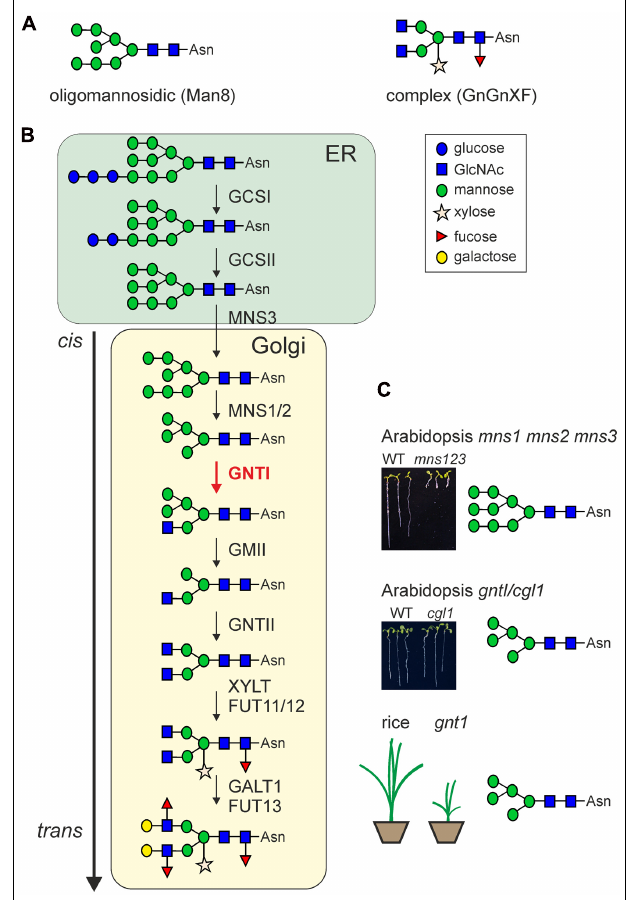
FIGURE 1 | (A) Examples for two characteristic types of N -glycans linked to the Asn–X–Ser/Thr sequence of proteins: oligomannosidic (e.g., Man8) and complex-type (e.g., GnGnXF) N -glycans. (B) Possible route in the formation of complex N -glycans in plants. Upon transfer of the preassembled oligosaccharide, the first N -glycan trimming reactions are catalyzed by α -glucosidases I (GCSI)/ II (GCSII) and α -mannosidase 3 (MNS3). Complex N -glycan formation is initiated in the Golgi apparatus by β 1,2- N -acetylglucosaminyltransferase I (GNTI, highlighted in red). MNS1/2, Golgi α -mannosidase I (two forms with largely redundant function are present in A. thaliana ); GMII, Golgi α -mannosidase II; GNTII, β 1,2- N -acetylglucosaminyltransferase II; XYLT, β 1,2-xylosyltransferase; FUT11/12, core α 1,3-fucosyltransferases (two forms with largely redundant function are present in A. thaliana ); GALT1, Lewis-type β 1,3-galactosyltransferase; FUT13, α 1,4-fucosyltransferase. Structural analysis of N -glycans from different A. thaliana mutants and in vitro enzyme activity assays revealed that downstream of GNTI the substrate specificity of the processing enzymes is less stringent (Strasser etal., 2006, 2007b). Not shown: the possible removal of terminal GlcNAc residues by β -hexosaminidases (HEXO proteins) which generates paucimannosidic N -glycans in post-Golgi compartments or in the extracellular space (Liebminger etal., 2011). (C) The phenotypes of characteristic N -glycan-processing mutants are shown. While an N -glycan-processing defect (mns1 mns2 mns3 ) upstream of GNTI results in a severe root and shoot phenotype in A. thaliana (Liebminger etal., 2009), cgl1 (or gntI , the allelic A. thaliana T-DNA knockout mutant) does not display any growth or developmental phenotype under normal